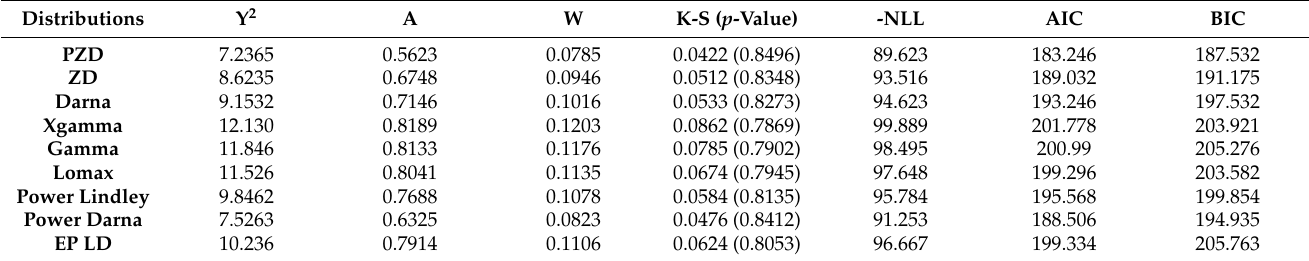
Table 12. Values of criteria statistics for model selection with glass fiber